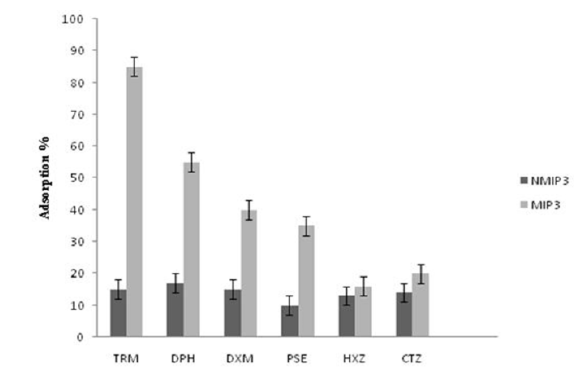
Figure 10. Curve of adsorption capacity obtained after the loading of 5 mL aqueous solution spiked with increasing amounts of tramadol onto the MIP particles (mean±S.D.,